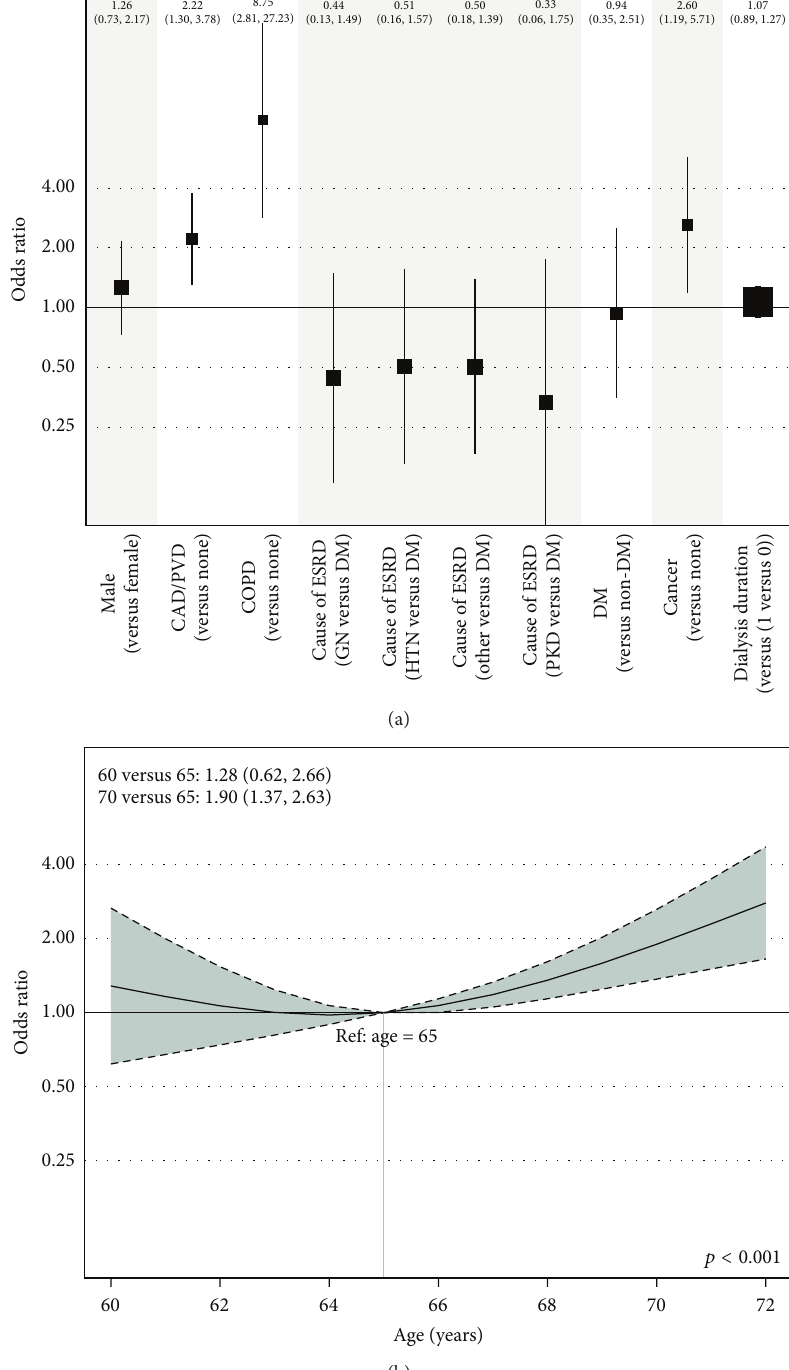
There was no significant difference in dialysis duration as most patients in both groups were either not yet on dialysis or had been on dialysis for less than a year at time of referral for transplant. Figure 2(a) shows the results from the primary analysis using a logistic regression model of the approval